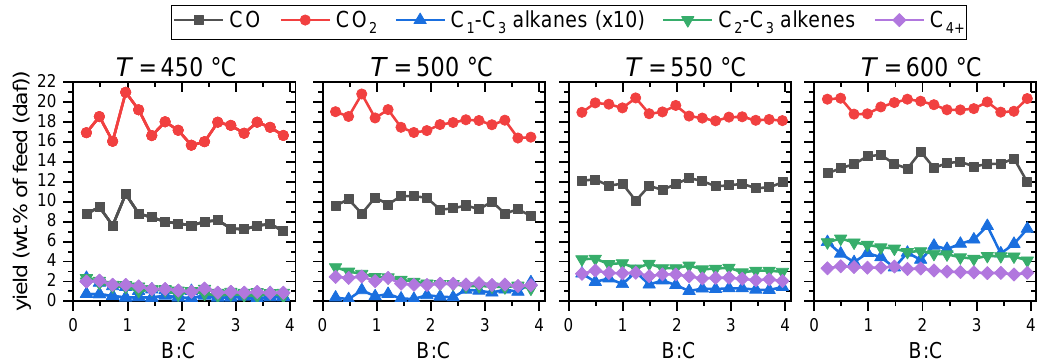
Figure 1. Change in momentary gas yields with increased biomass injection at constant temperatures (450, 500, 550, and 600 °C) of catalyst P/HZSM-5/γ-Al 2 O 3 . The yield of C 1 -C 3 alkanes was multiplied by a factor of 10.